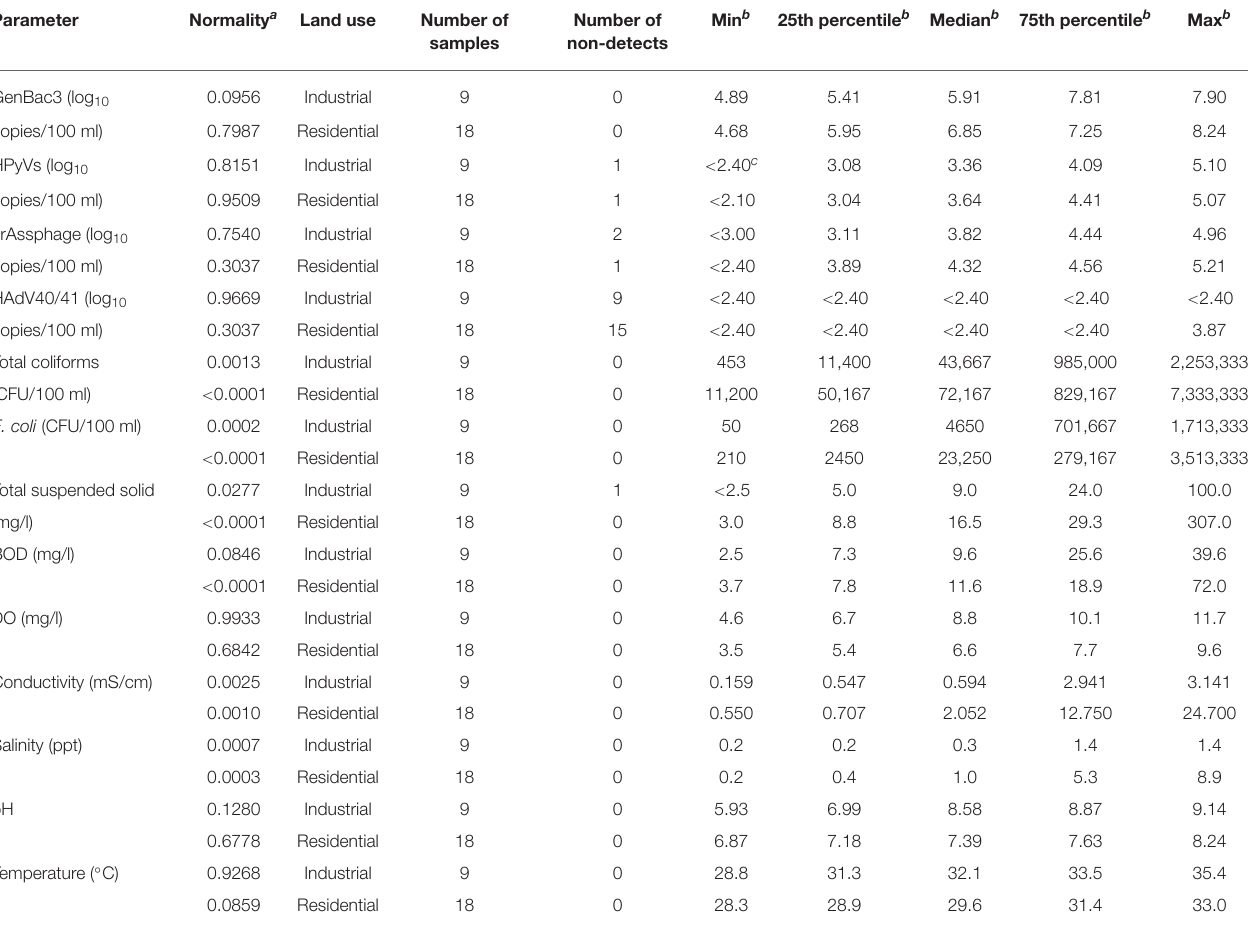
TABLE 1 | Descriptive statistics of microbial and physicochemical water quality